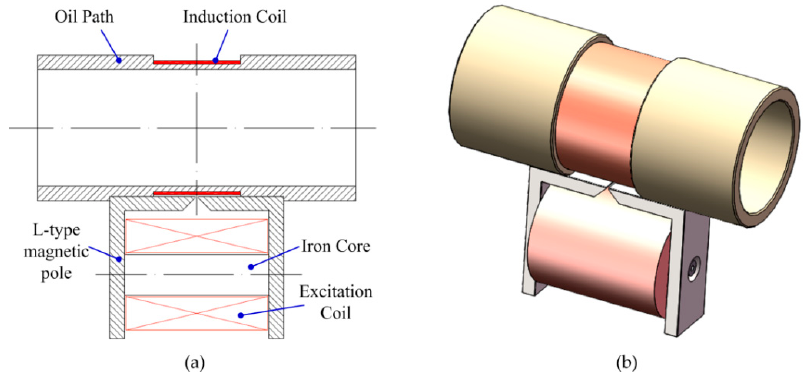
Figure 1. The structure diagram of the induction sensor: ( a ) cutaway view; and ( b ) 3-D model.